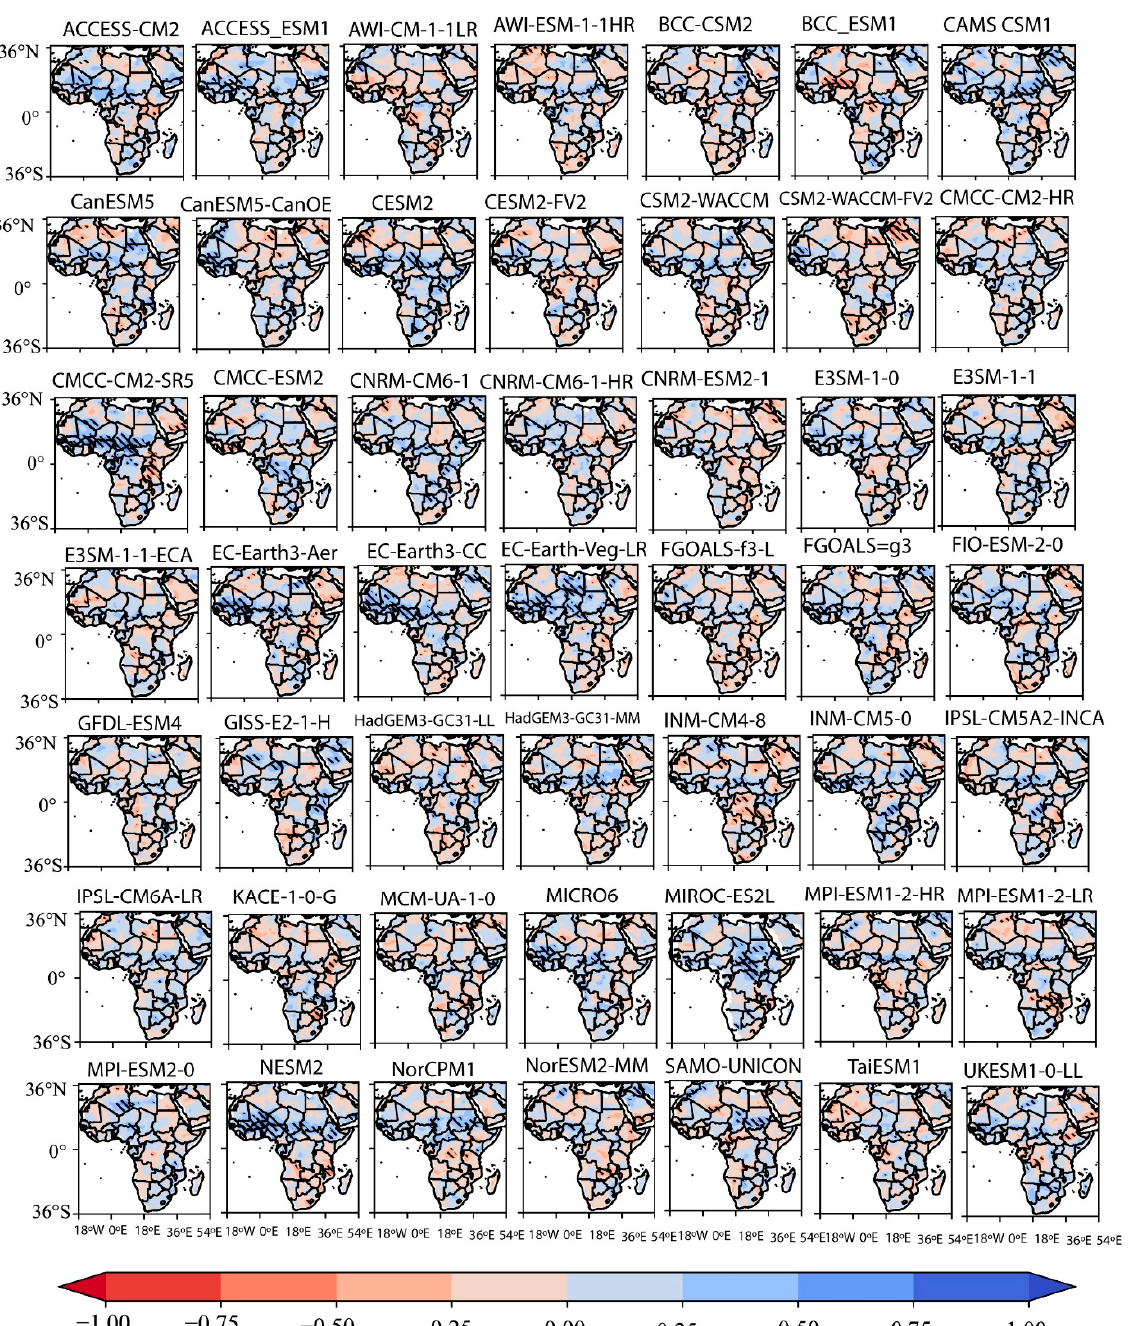
Figure 11. Spatial distributions of annual correlation coefficients of 49 selected CMIP6 models and SST during 1980–2014. Hatched area indicates a 95% confidence